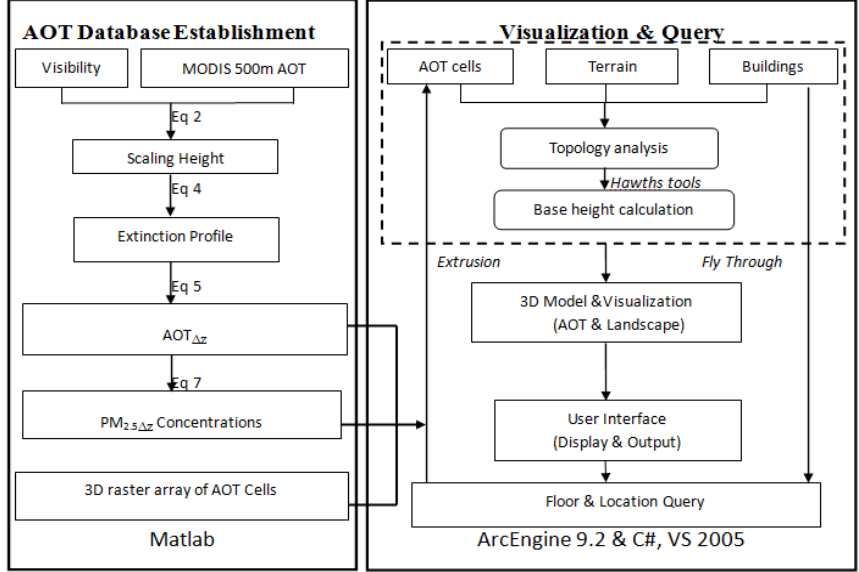
Figure 2. The schematic flow chart of the